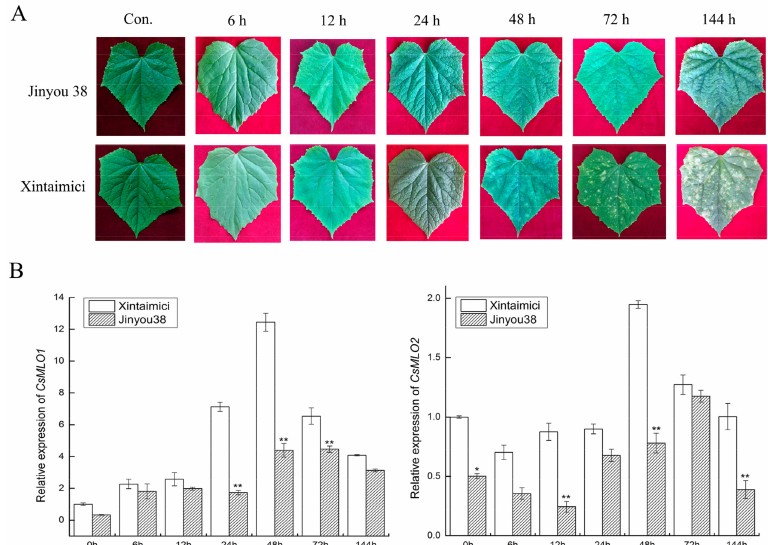
Figure 2. The phenotype and expression patterns of C sMLO in Jinyou38 and Xintaimici cultivars were inoculated with C. cassiicola. ( A ) Symptoms analysis in leaves of Jinyou 38 and Xintaimici cultivars after C. cassiicola challenge. ( B ) The transcript levels of CsMLO1 and CsMLO2 are shown in Jinyou 38 and Xintaimici cultivars after inoculation of C. cassiicola . Expression analysis of candidate genes at 0, 6, 12, 24, 48, 72 and 144 hpi (hours post-inoculation) using the 2 − ∆∆ Ct method. Data are means ( ± standard deviation (SD)) of three biological replicates per cultivars. The asterisks indicated a significant di ff erence (Student’s t -test, *P < 0.05 or ** P < 0.01). Jinyou38 = high-resistant cultivar. Xintaimici = susceptible